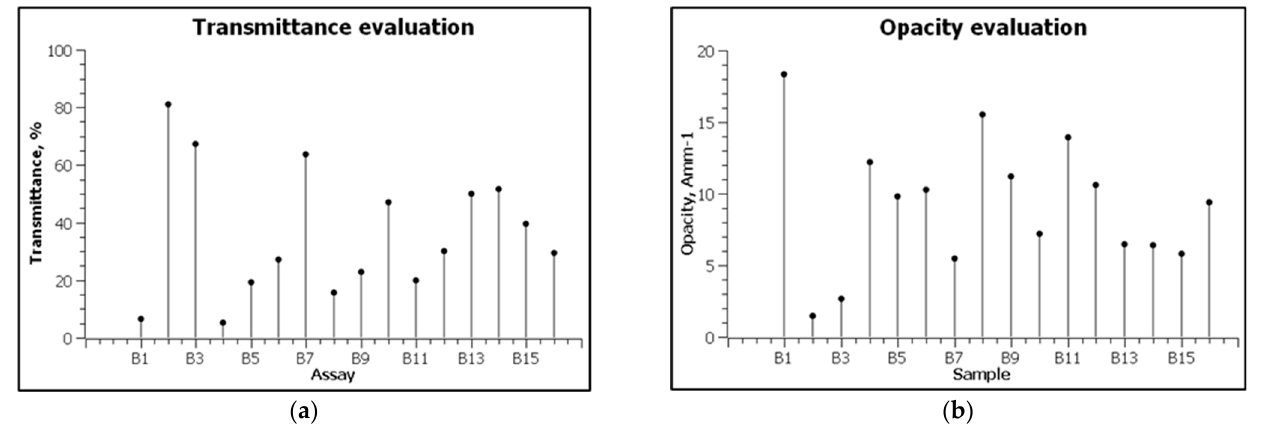
Figure 4. The transmittance ( a ) and opacity ( b ) of developed films.